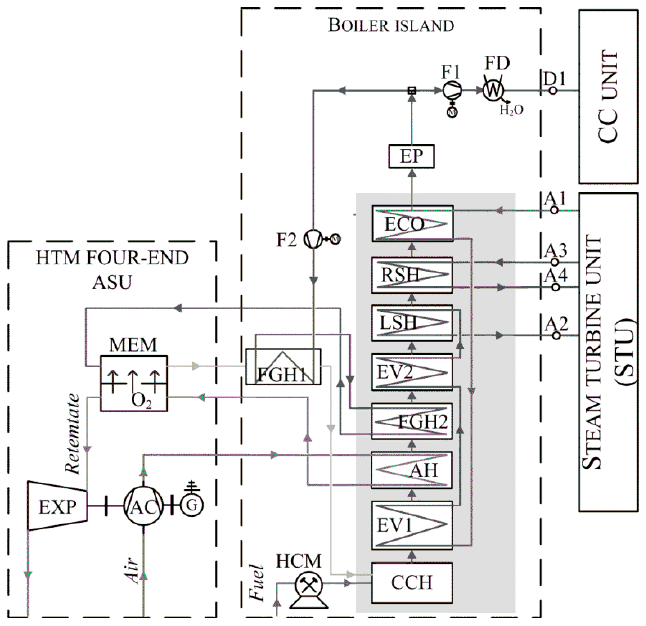
Figure 7. Scheme of the pulverized-fuel boiler integrated with an ASU equipped with a four-end type HTM [67,68].